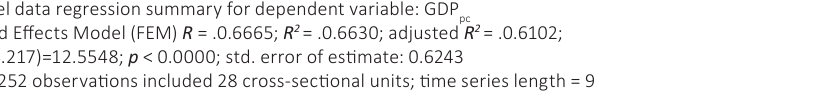
Table 4. Panel data regression analysis between GDP